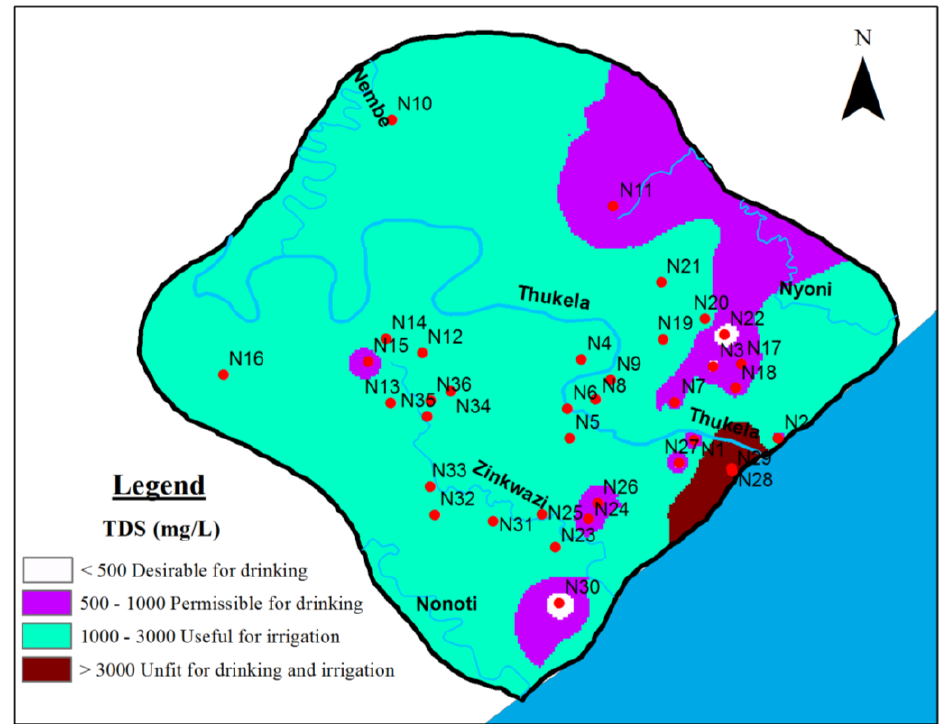
Figure 12. Groundwater suitability zone for drinking and irrigation.